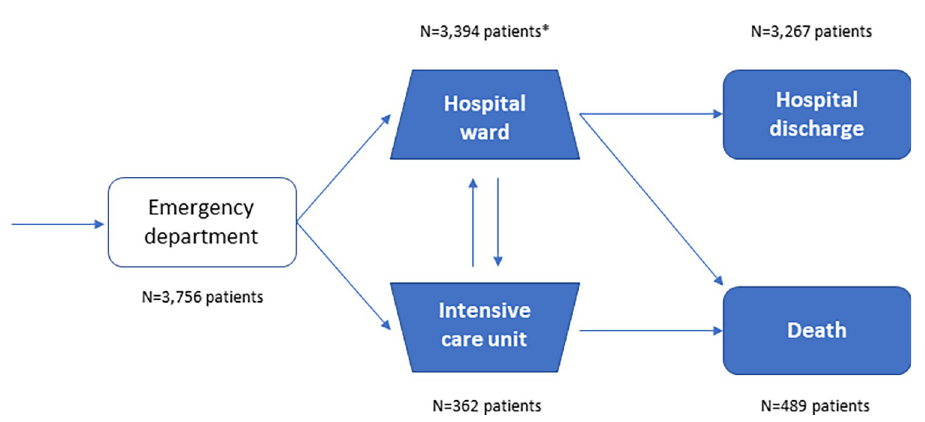
Fig 2. Inpatient pathway of the study cohort. � Patients who were only admitted to the hospital